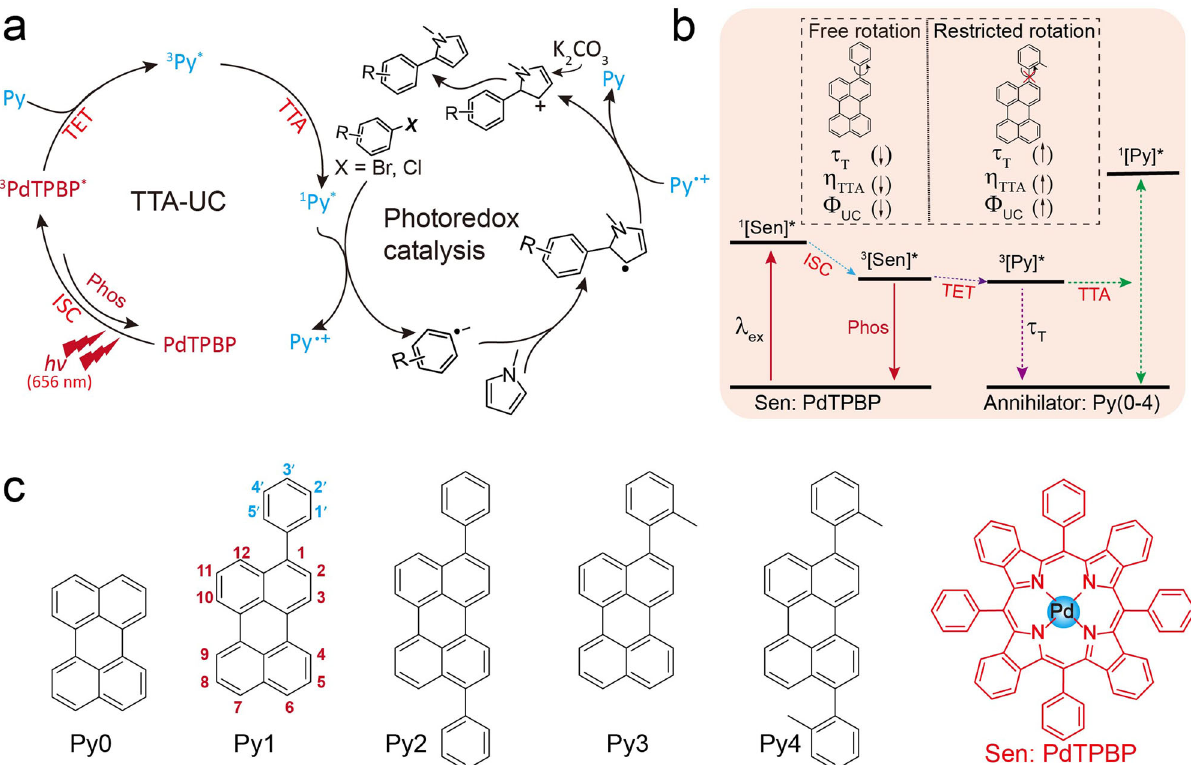
Fig. 1 | Realization of red light-driven sacri fi cial agent-free photoactivation of aryl halides. a The proposed mechanism of red light-driven sacri fi cial agent-free photoactivation of aryl halides via our TTA strategy; b Jablonski diagram showing the mechanism of restricting aryl rotation of Py annihilator to enhance TTA ef fi - ciency. c Molecular structures of photosensitizer PdTPBP and annihilators of